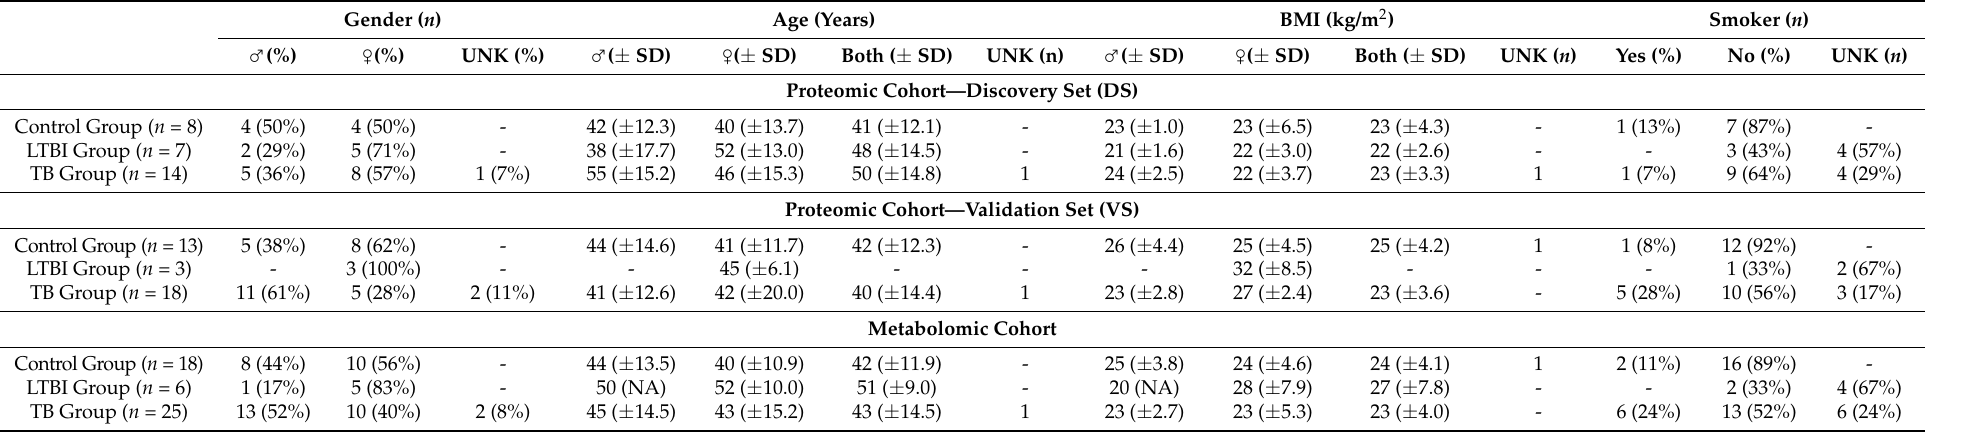
Table 2. Demographic features of each of the cohorts enrolled in this